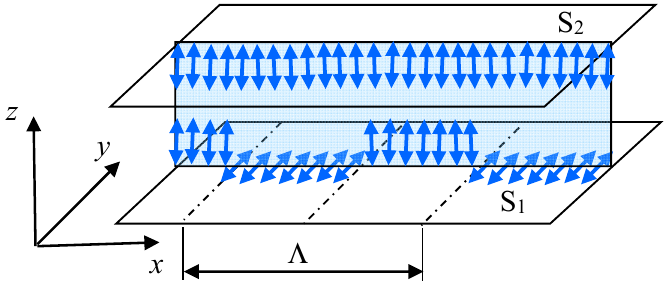
Figure 1. The scheme of the boundary conditions at cholesteric liquid crystal (CLC) layer alignment surfaces S 1 and S 2. The distributions of the easy axes are shown by arrows. Infinite anchoring energy (rigid boundary conditions) is used at both